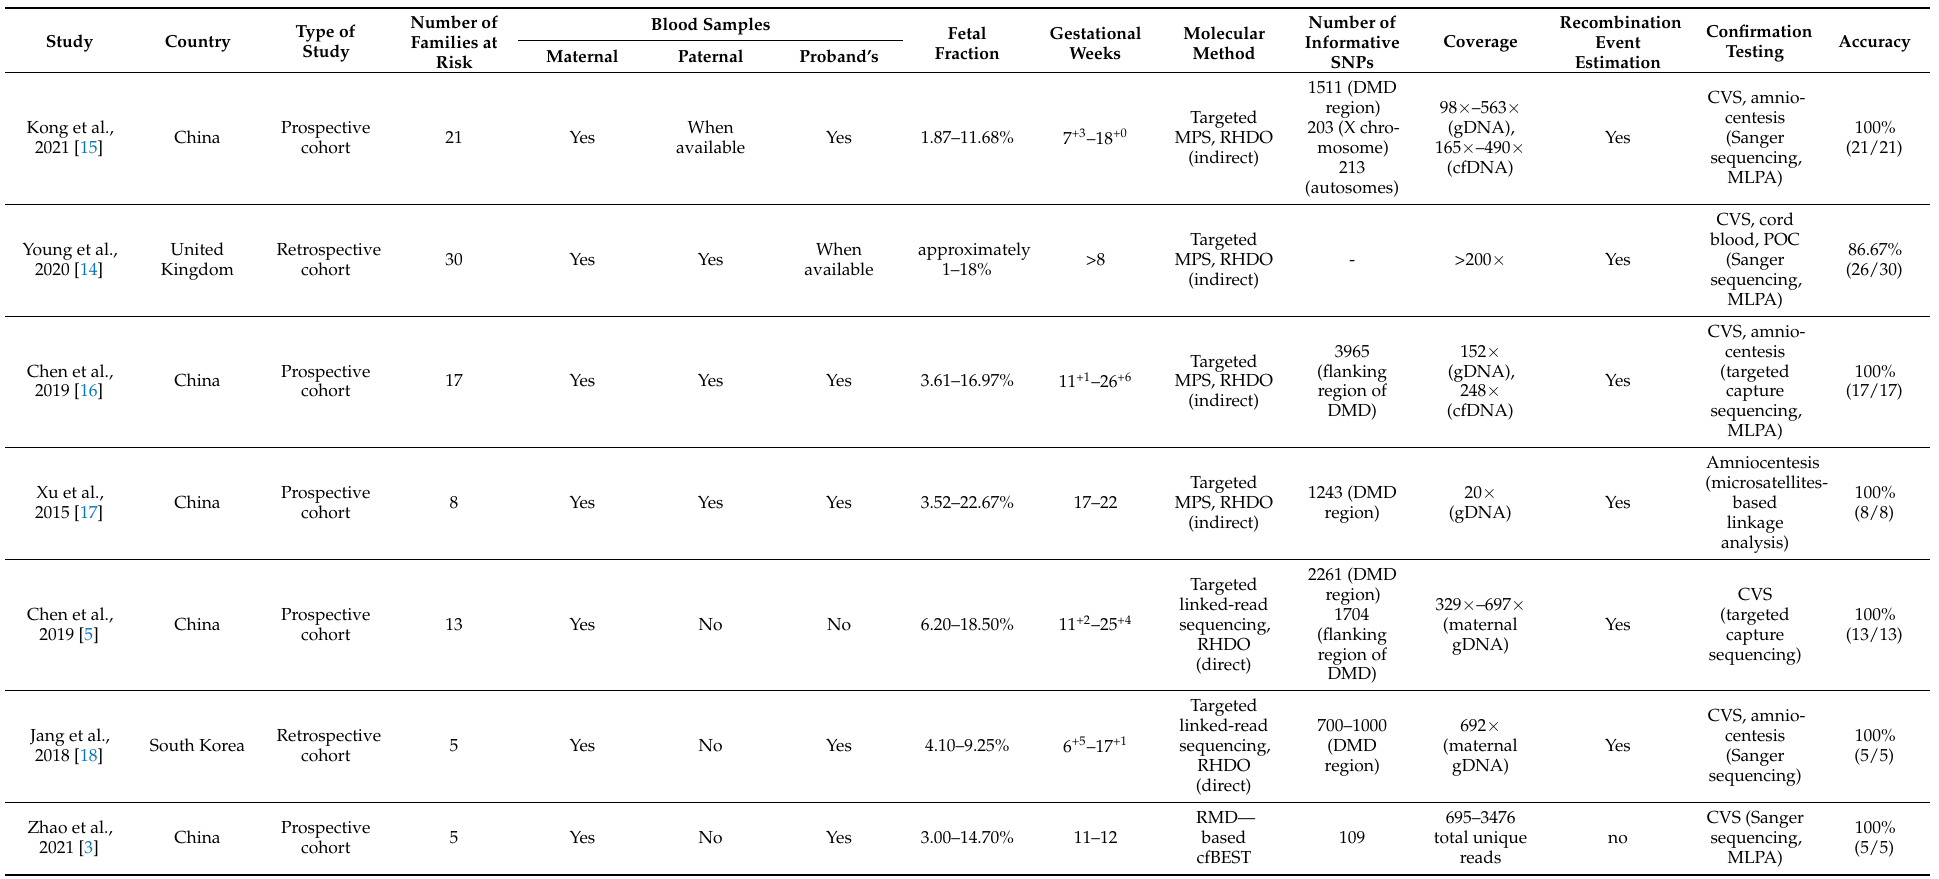
Table 1. Studies included in the systematic